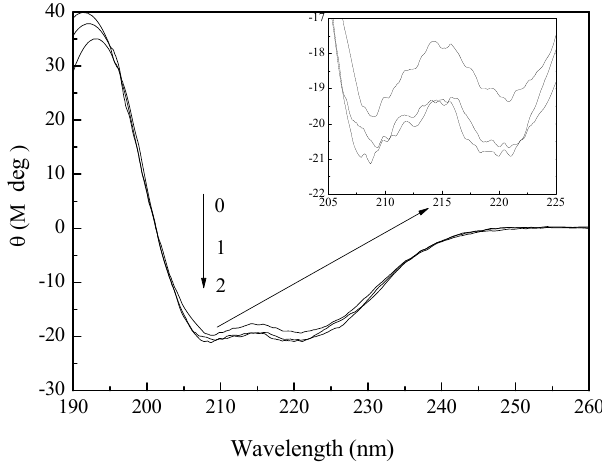
Figure 5. The molar ellipticity CD curves for HSA solutions before and after addition of